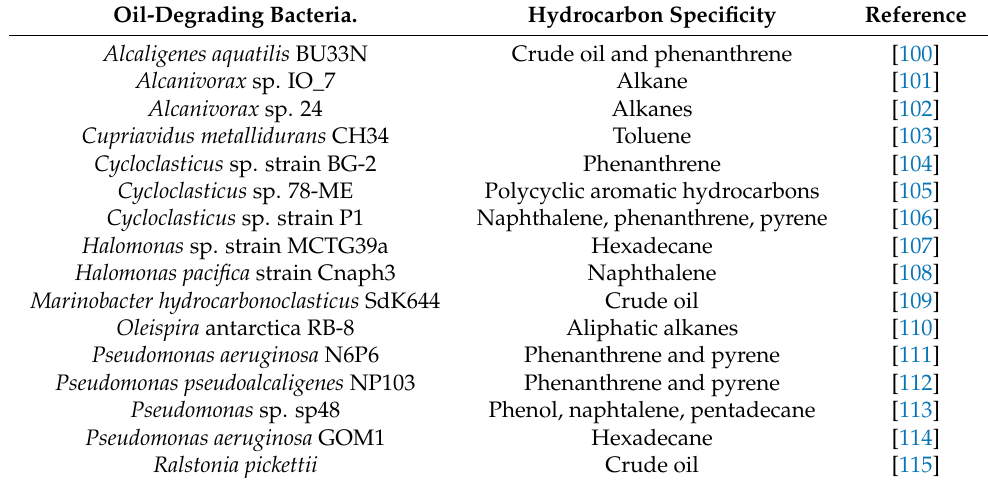
Table 2. An overview of oil degrading bacteria isolated from different marine ecosystems and their hydrocarbon